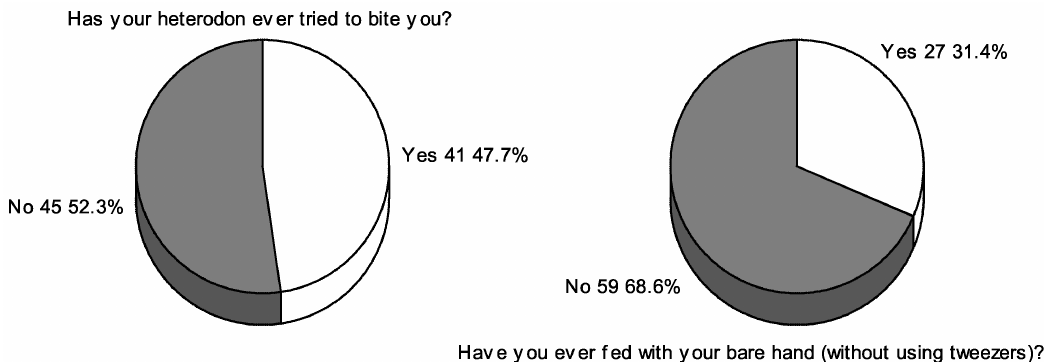
Figure 1. Respondents’ answers to questions related to bite incidents and applied feeding